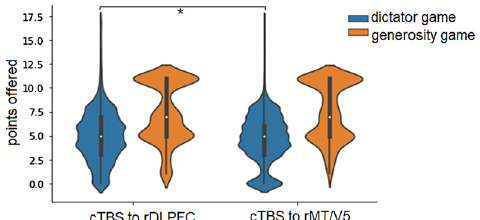
Figure 2. Allocations to recipients in the dictator game and the offered pie size in the generosity game. The blue violin plot indicates the results of the dictator game, and the orange violin plot indicates the results of the generosity game. The data correspond to cTBS under the following experimental conditions: rDLPFC = cTBS of the rDLPFC; MT/V5 = control cTBS of the MT/V5. Note : The bottom of the violin plot indicates the minimum, the lower bar of the boxplot denotes the first quartile (Q1), the white dot denotes the median, the higher bar of the boxplot denotes the third quartile (Q3), and the top of the violin plot indicates the maximum. An asterisk (*) indicates significance at p < 0.05 (Mann–Whitney U test).